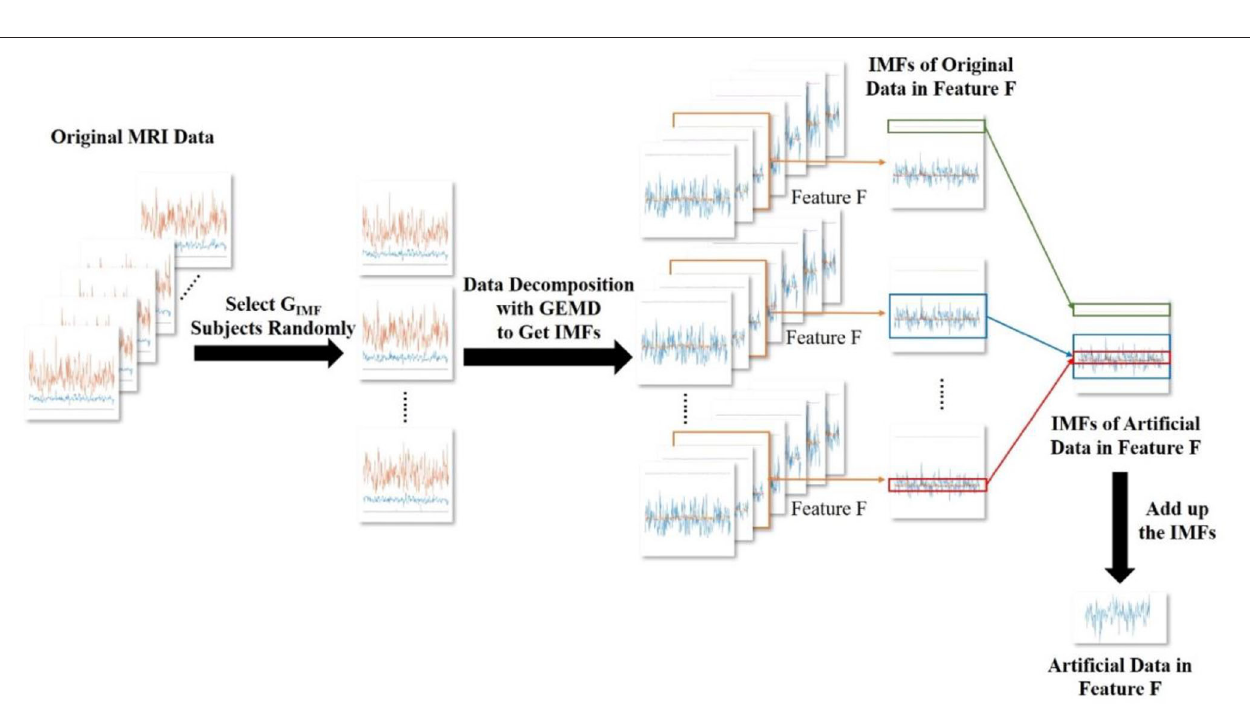
FIGURE 4 | The generation of artificial MRI data. Here, we generate the artificial data in feature F as an example. We randomly select M subjects from the original MRI data. Then, we obtain the IMFs, which are decomposed with GEMD. The IMFs decomposed form feature F of the M randomly selected subjects are recombined. Then, they are added up to obtain the artificial data of the feature